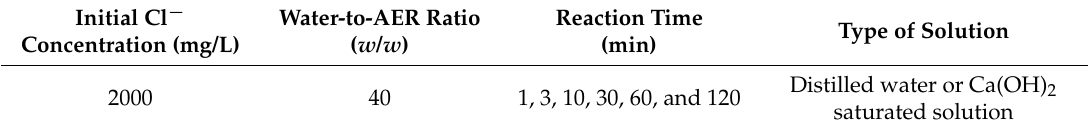
Table 2. Experimental conditions of the kinetic test in chloride solutions containing the AER. Water-to-AER Initial Cl − Concentration (mg/L)